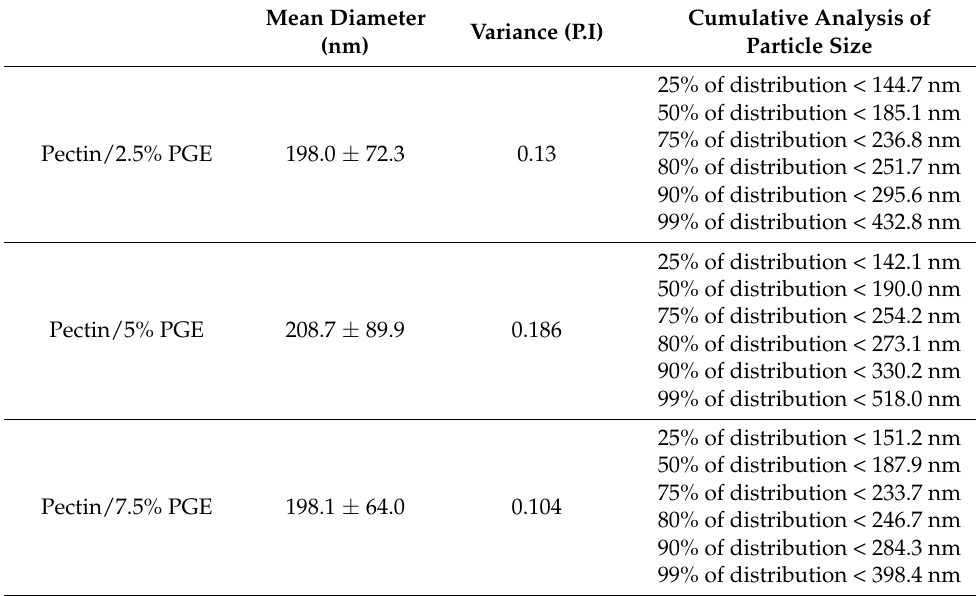
Figure 2. Particle size analysis histograms of Pectin/PGE emulsions with different PGE loadings: ( a ) 2.5% PGE, ( b ) 5% PGE, ( c ) 10% PGE, ( d ) 15% PGE, and ( e ) 20% PGE. Table 2. Particle size analysis of Pectin/PGE emulsions with different PGE loadings.